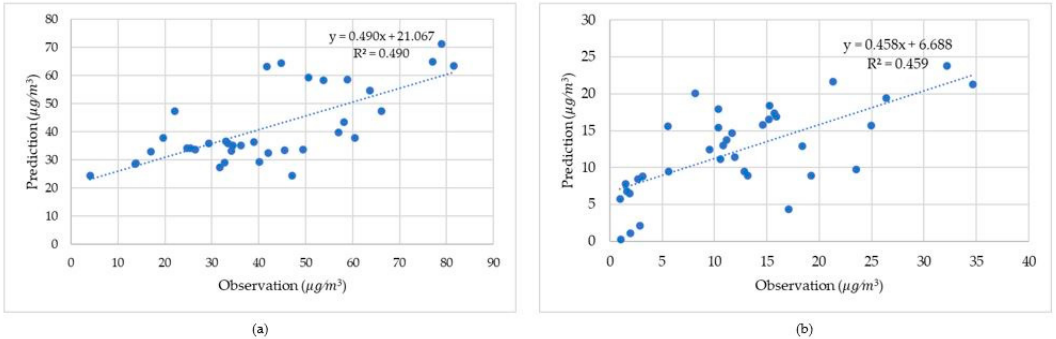
Figure 8. External verification using GWR based on observations regressed against predictions. ( a )